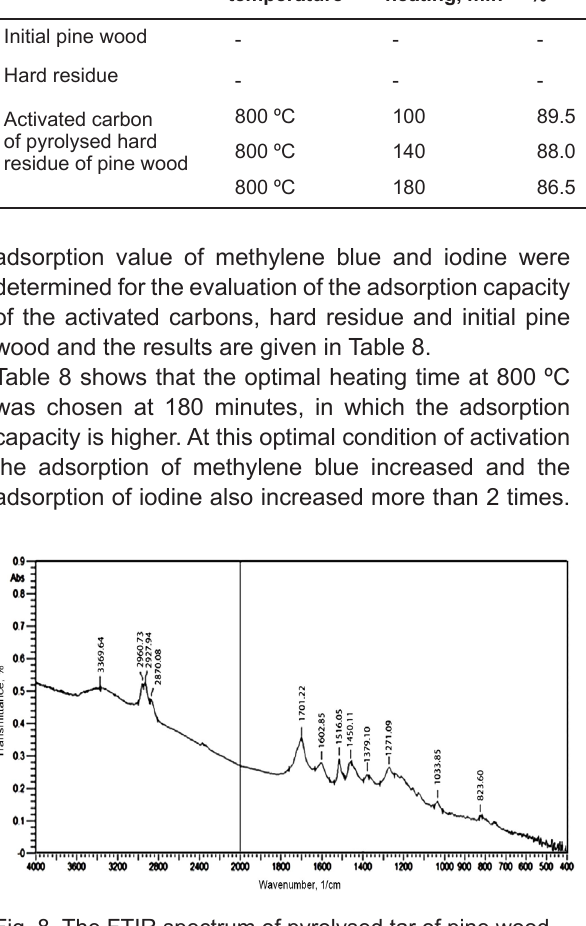
Fig. 8. The FTIR spectrum of pyrolysed tar of pine wood Table 9. Functional groups and the modes of vibrations at various peaks